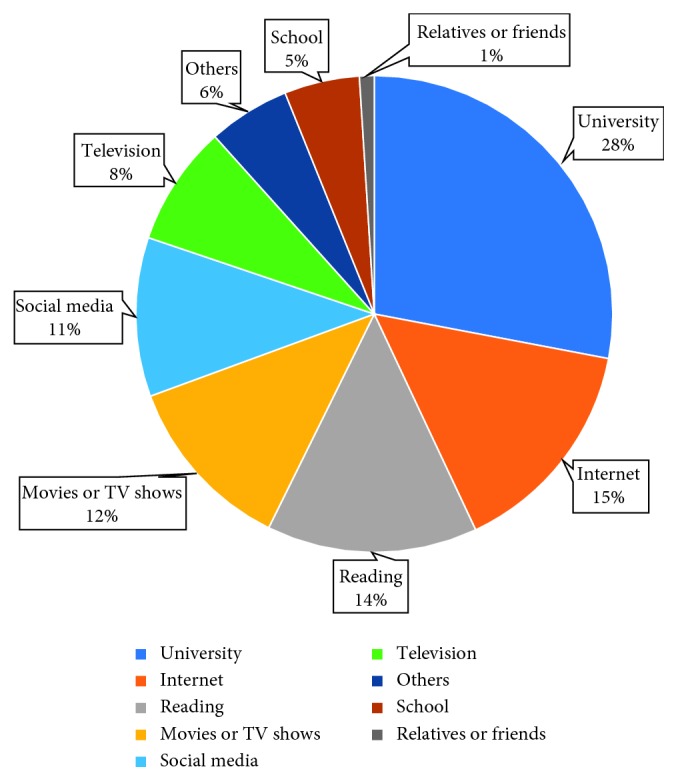
The sources of CPR knowledge.